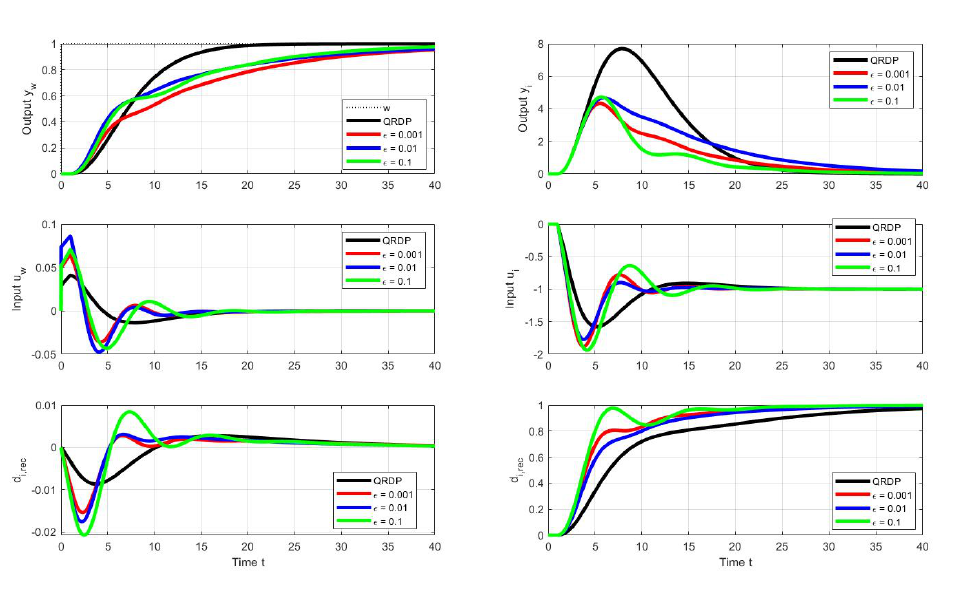
Figure 11. Unit setpoint step responses ( left ) and unit input disturbance step responses ( right ) achieved with the parallel QRDP PID controller (black) and responses corresponding to series PID controller (see Figure 9) with the optimal tuning calculated by the PPM over the parameter grid (41) under the output performance specifications (53) and (44) and the input admissible deviations (55); T m = 1; K s = 1; T s = 0.001.